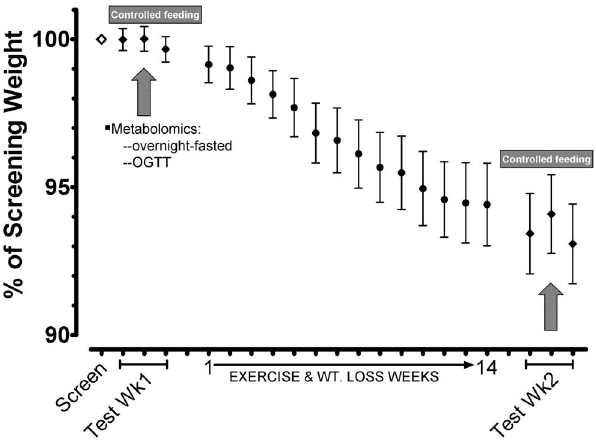
Figure 1. Study schematic and weight loss patterns in obese, sedentary women undergoing a fitness and weight loss intervention to assess changes in the plasma metabolome. Blood was drawn in the overnight-fasted and post-OGTT conditions, during each of pre-intervention and post-intervention Test Weeks identically controlled for dietary intake, weight maintenance, and physical activity. To match menstrual cycle stage within individuals, Test Week 2 was after an intervention period ranging from 14-17 weeks (14 week time point mean is depicted for clarity). Of 15 women completing Test Week 1, 12 remained throughout the study to finish Test Week